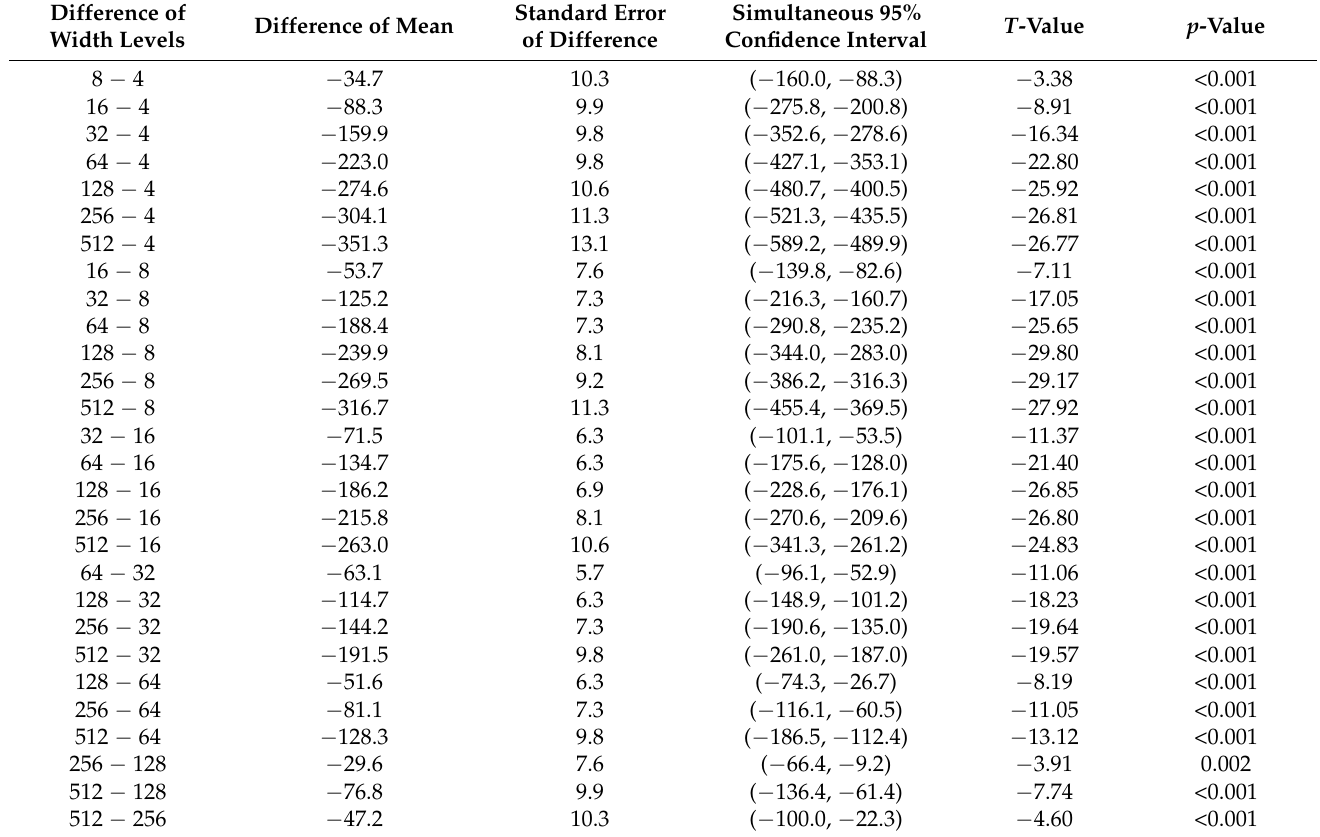
Table 7. Tukey simultaneous tests for differences of means in width. The smaller the width was, the longer the MT